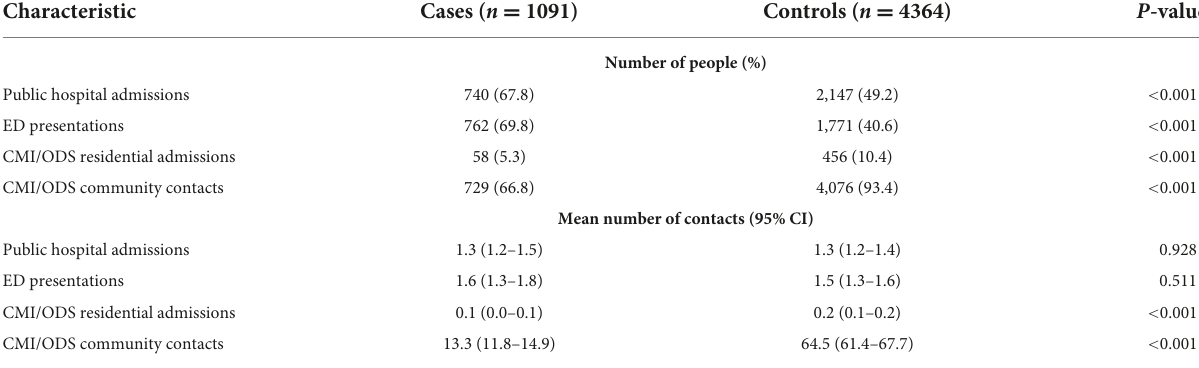
TABLE 3 Patients with at least one mental health contact by service type.